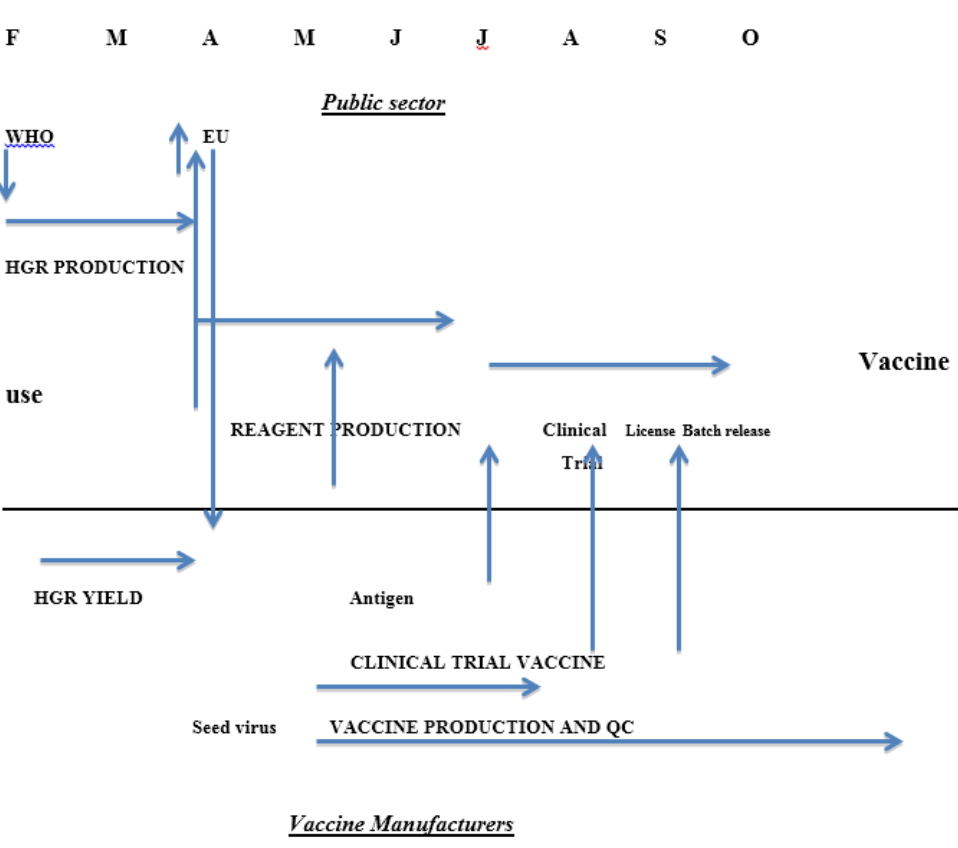
Figure 1. Calendar of influenza vaccine production in the European Union showing roles of the public sector bodies and vaccine manufacturers and the interactions between